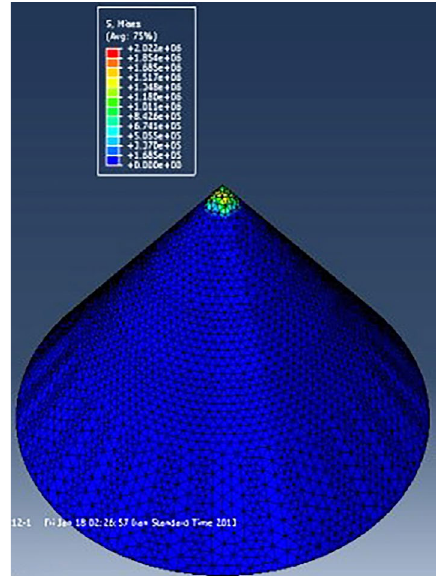
Fig. 13. Von misses composite stress contour in the conical Building in a moment after explosion strikes Building on the ground